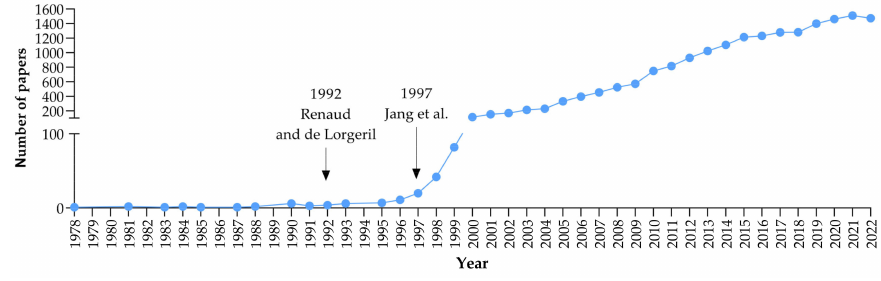
Figure 2. Resveratrol-related papers published in Pubmed.gov from 1978 to 2022, with significant acceleration visible after 1992 Renaud and de Lorgeril [3] and 1997—Jang et al. [16].